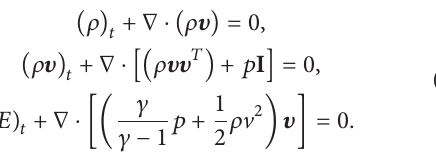
the number of processors which is encouraging. On the same figure speedup and efficiency are close to ideal (red dashed line), with efficiency values ranging between 94 % and 100